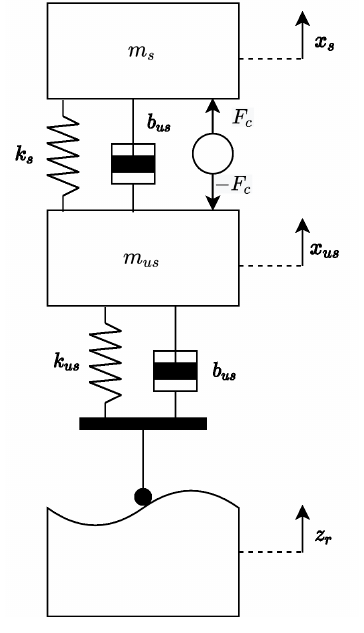
Figure 1. Quarter